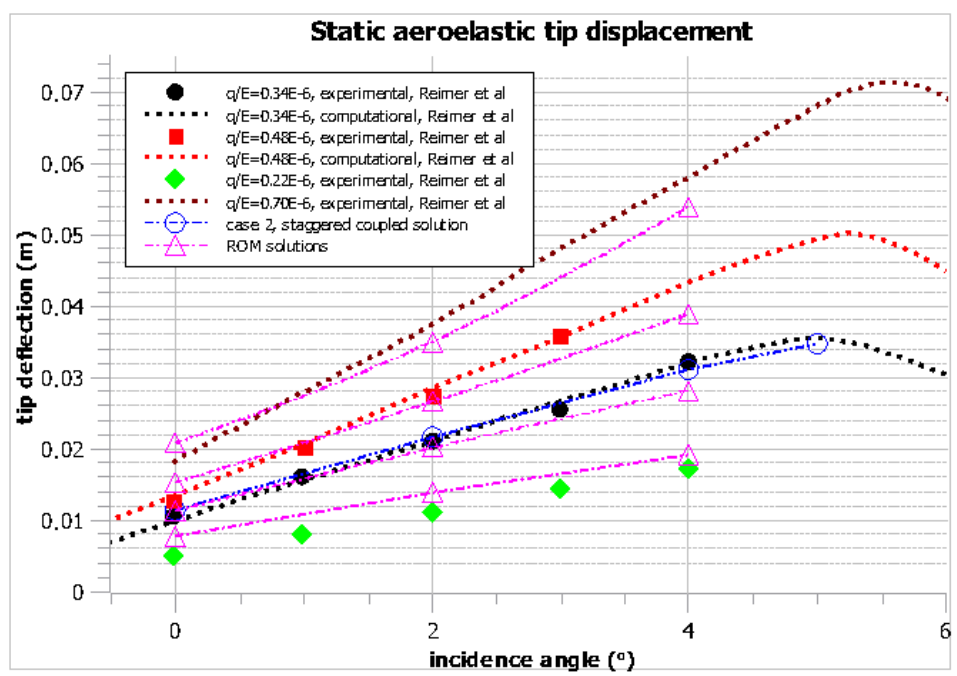
Figure 16. Case 2: static aeroelastic vertical displacement at several incidence angles and dynamic pressure